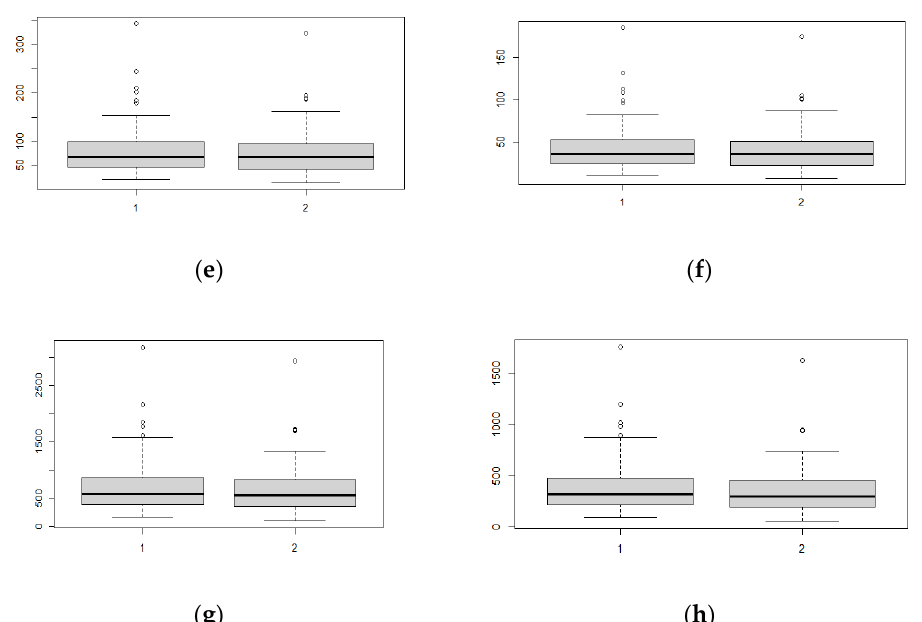
Figure 7. ( a ) Boxplot of circumference at 1.30 m (cm) measured and estimated with field data col- lection (1) and from UAV-ALS-TLS data (2), ( b ) boxplot of tree height (m) measured and estimated with field data collection (1) and from UAV-ALS-TLS data (2), ( c ) boxplot of aboveground biomass (kg) measured and estimated with field data collection (1) and from UAV-ALS-TLS data (2), ( d ) boxplot of aboveground carbon stock (kg) measured and estimated with field data collection (1) and from UAV-ALS-TLS data (2), ( e ) boxplot of belowground biomass (kg) measured and esti- mated with field data collection (1) and from UAV-ALS-TLS data (2), ( f ) boxplot of belowground carbon stock (kg) measured and estimated with field data collection (1) and from UAV-ALS-TLS data (2), ( g ) boxplot of Total biomass (kg) measured and estimated with field data collection (1) and from UAV-ALS-TLS data (2), and ( h ) boxplot of Total carbon stock (kg) measured and estimated with field data collection (1) and from UAV-ALS-TLS data (2). To compare the means, we first study the distribution of data and then compare the means with the appropriate test. The representation by histograms, show that distribu- tions of tree height and circumference at 1.30 m measured by field field data collection and the circumference at 1.30 m extracted from UAV-ALS-TLS data, do not seem to fol- low a normal distribution, except tree height extracted from UAV-ALS-TLS data (Figure 8).